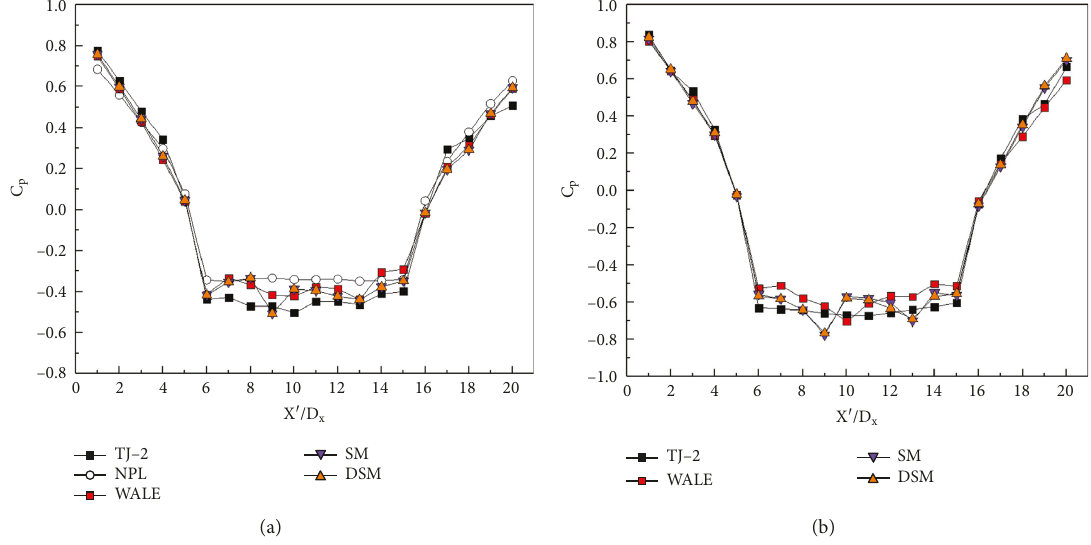
Figure 5: Average wind pressure coefficient at 45 ° wind direction angle. (a) Class D wind farm. (b) Class B wind